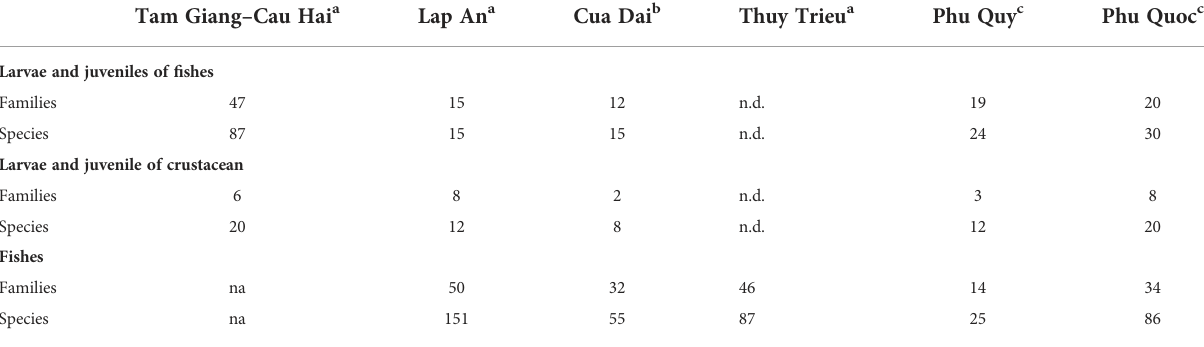
TABLE 2 Number of families and species of zoobenthos in seagrass